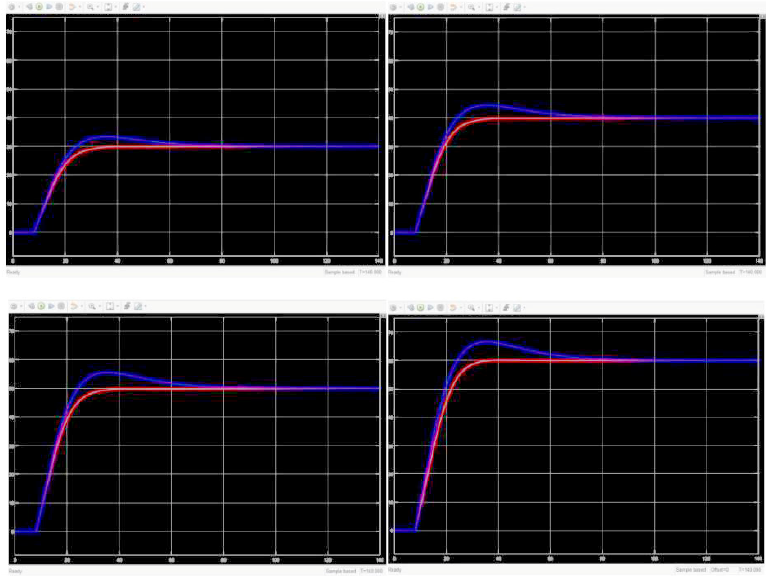
Figure 17. System simulation results.